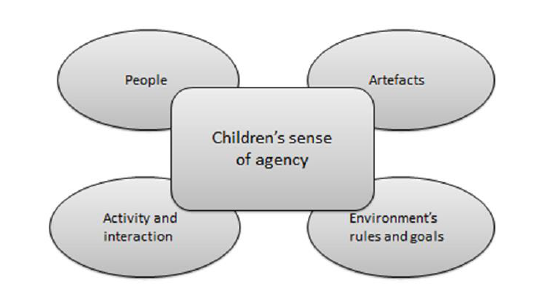
Figure 8. The sociocultural resources related to the children’s sense of